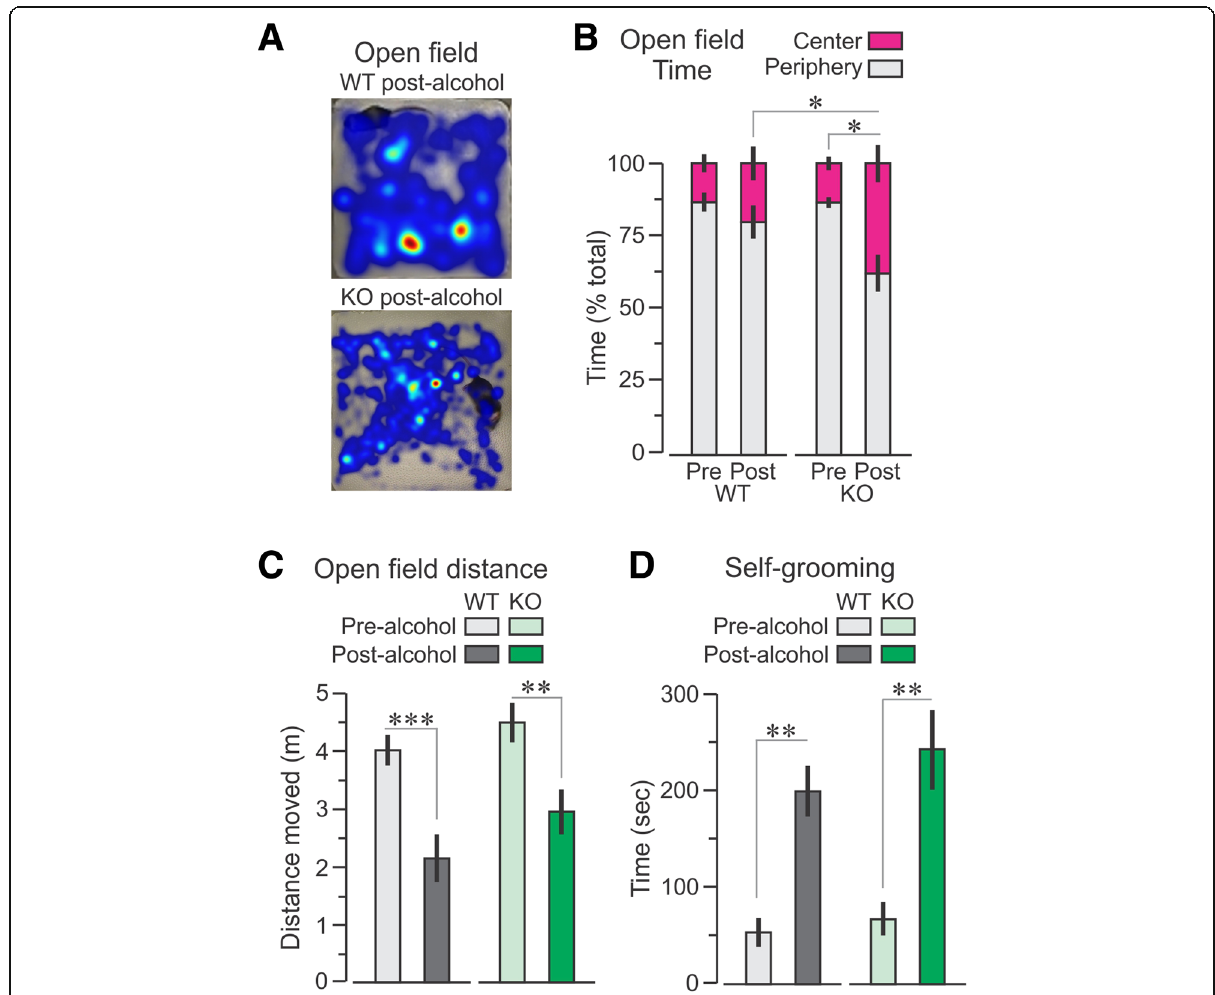
Fig. 4 Deficiency in CIRP inhibited the altered open field behavior exhibited by WT mice. a Representative heat map of WT and CIRP − / − mice exploring the chamber. b Percent time spent exploring either the center or periphery of the chamber. c Total distance traversed during the test. d Time spent for self-grooming during the OF tasks. Data are expressed as mean ± SE; * P < 0.05; ** P < 0.005, *** P < 0.001 by